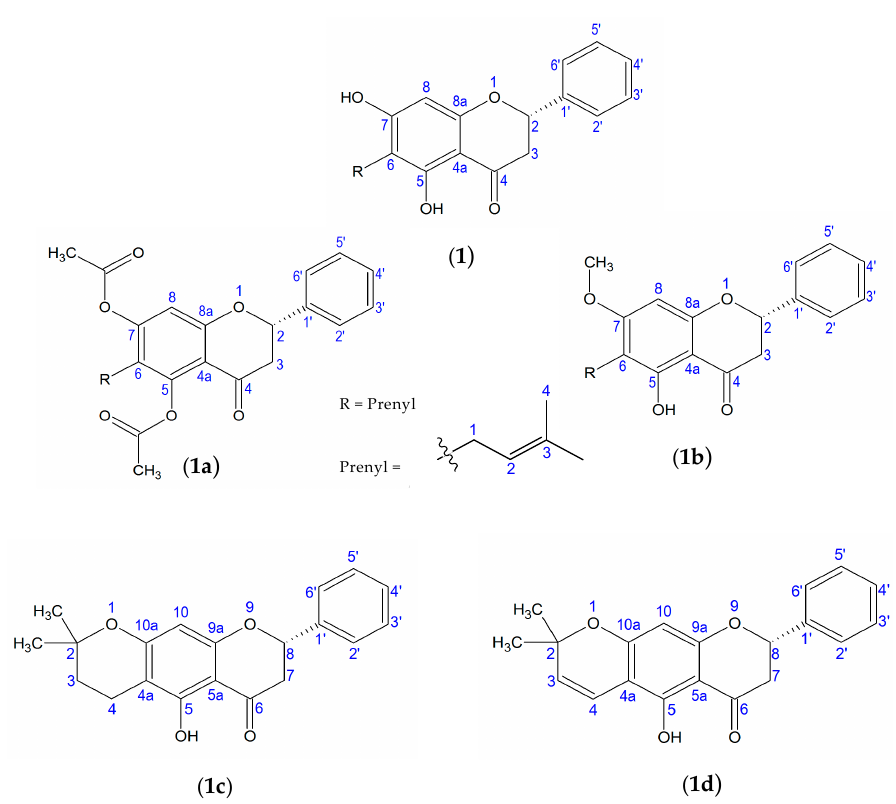
Figure 1. Chemical structures of the studied compounds. (2 S )-5,7-dihydroxy-6-(3-methyl-2-buten-1-yl)-2-phenyl-2,3-dihydro-4 H -1-Benzopyran-4-one ( 1 ); (2 S